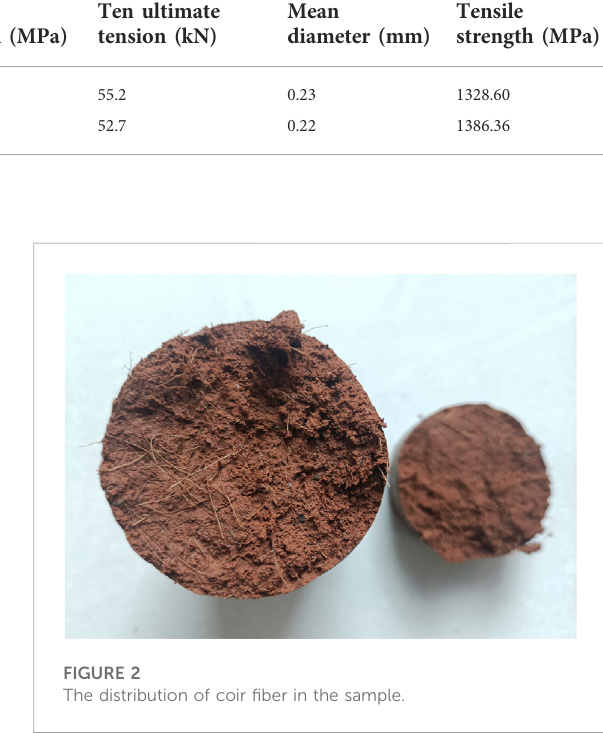
FIGURE 2 The distribution of coir fi ber in the